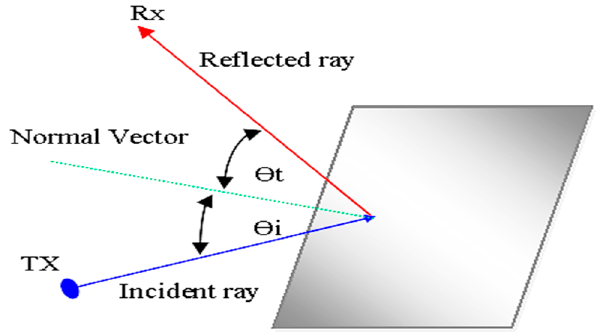
Figure 6. Graphical presentation of reflection.